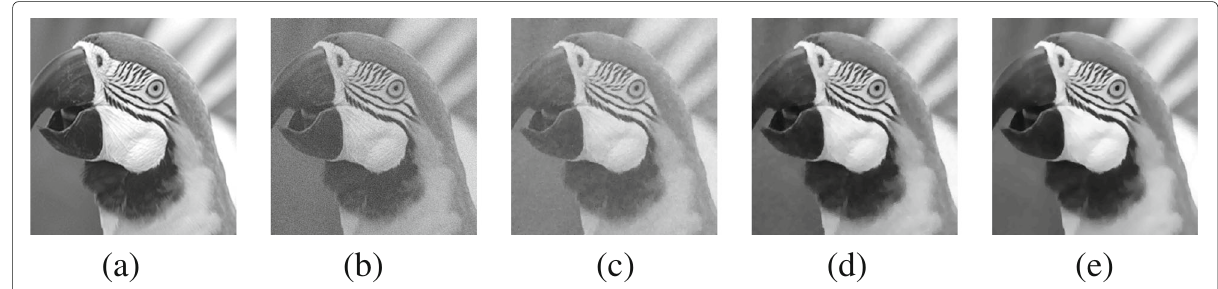
Fig. 3 Denoised results on Parrot; a original image; b noisy image with additive Gaussian noise σ = 18; c recovered image by method M1; d recovered image by method M2; e recovered image by method